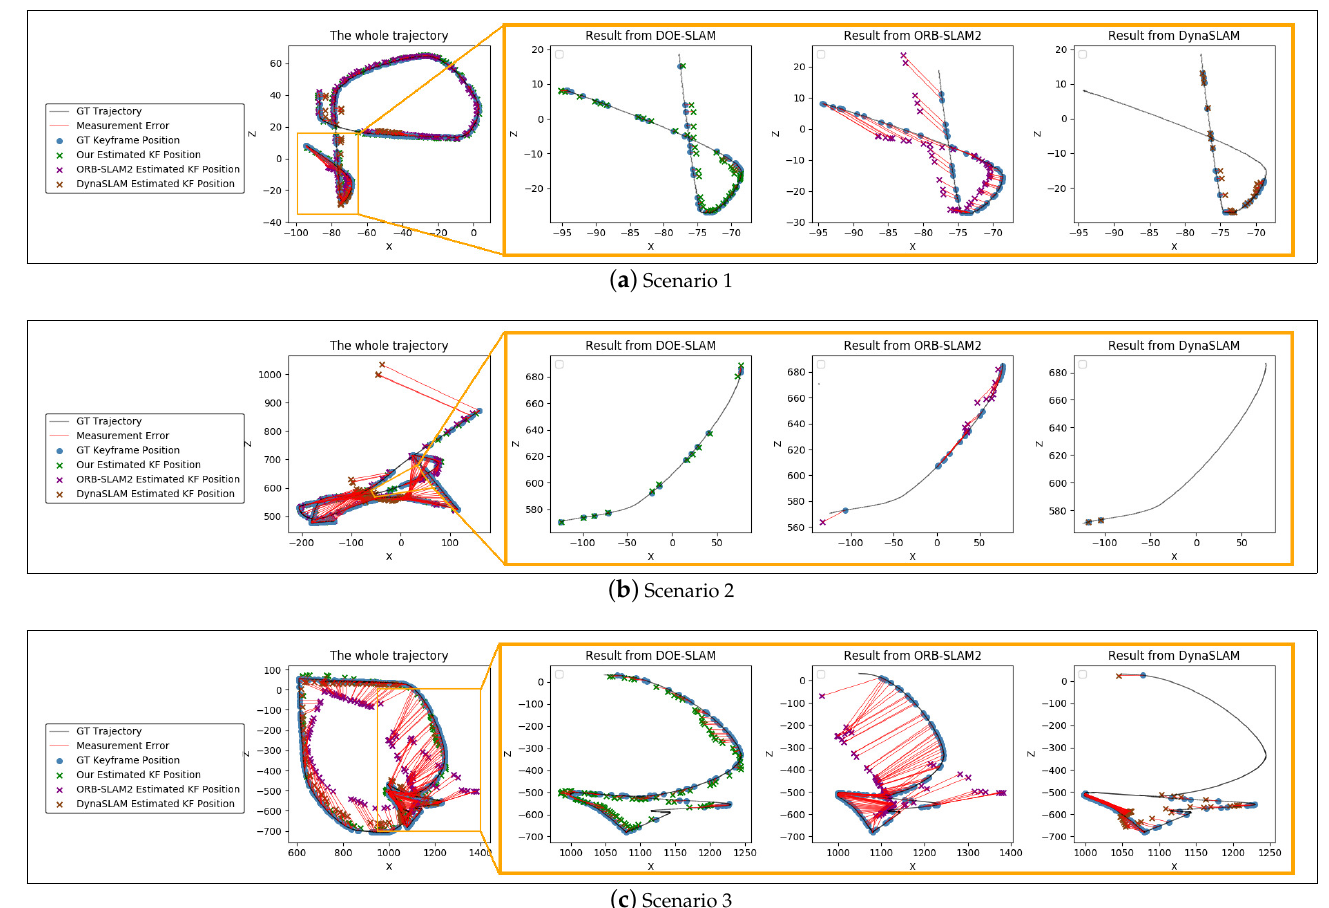
Figure 5. Motion of previously static objects. Overview of complete trajectories with marked successful tracking steps for DOE-SLAM, ORB-SLAM2, and DynaSLAM, and zoom-in to the region where the moving object is in